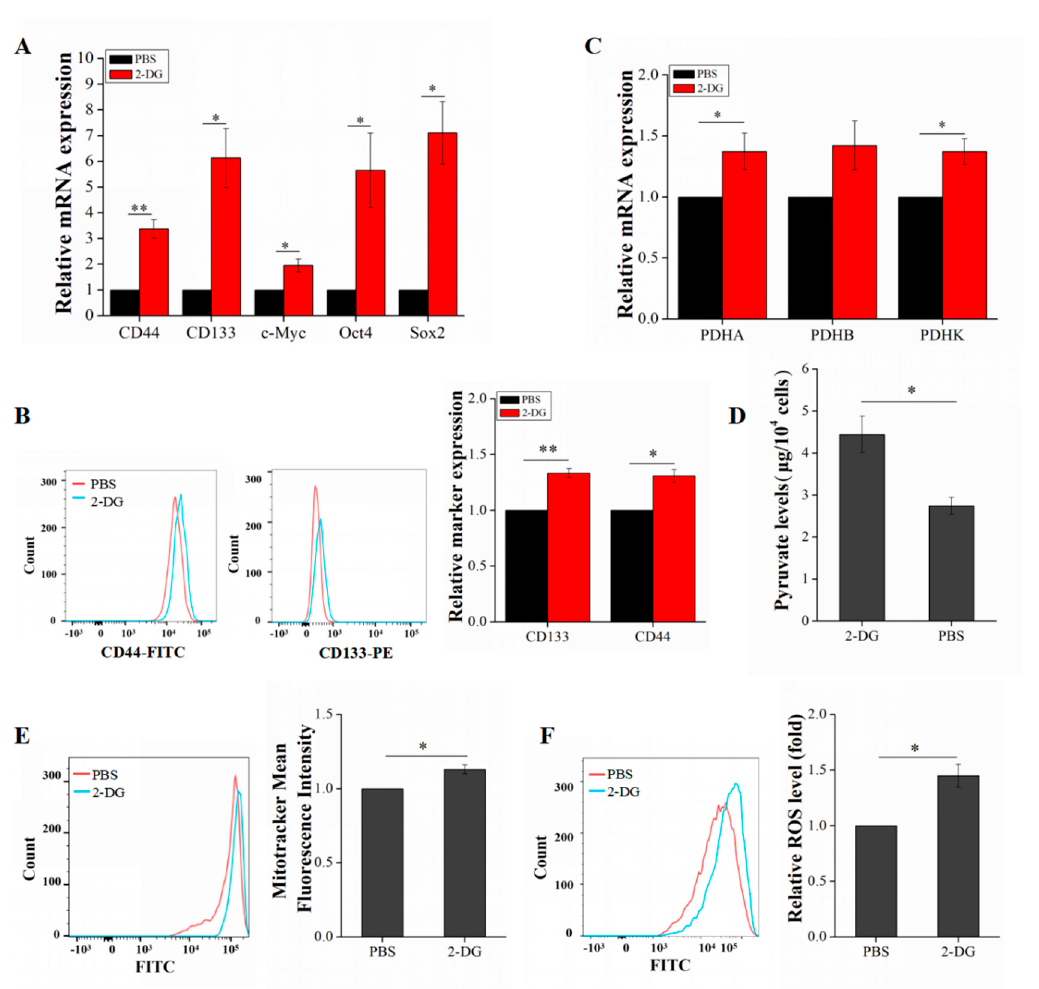
Figure 4. Assessment of LCSC metabolism and stemness gene expression after 2-DG treatment. ( A ) Detection of stemness genes after 2-DG treatment. ( B ) Detection of the surface markers CD133 and CD44 after 2-DG treatment. ( C ) Comparison of PDHC expression after 2-DG treatment. ( D ) Comparison of pyruvate levels after 2-DG treatment. ( E ) Measurement of the mitochondrial mass after 2-DG treatment. ( F ) Measurement of the ROS level after 2-DG treatment. The values are presented as the means ± SD of three independent experiments. n = 3; * p < 0.05; ** p < 0.001.